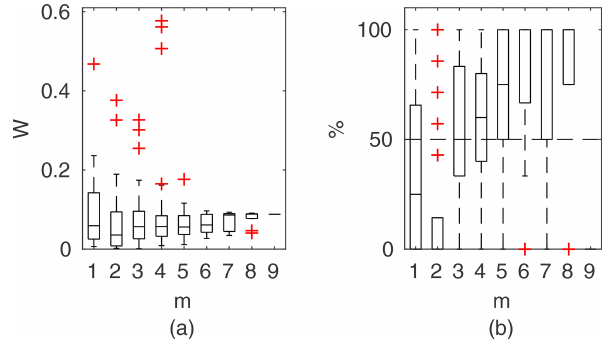
Figure B2. Pasche results for flume case 1: (a) averaged relative confidence widths W as a function of observation set size m used for model identification; (b) percentage of verification points en- closed by the confidence intervals (100% denotes all points within intervals, box spans over the 25% and 75% quantiles, the median is given with horizontal line, whiskers indicate the result extent, and cross marks are for extreme values).